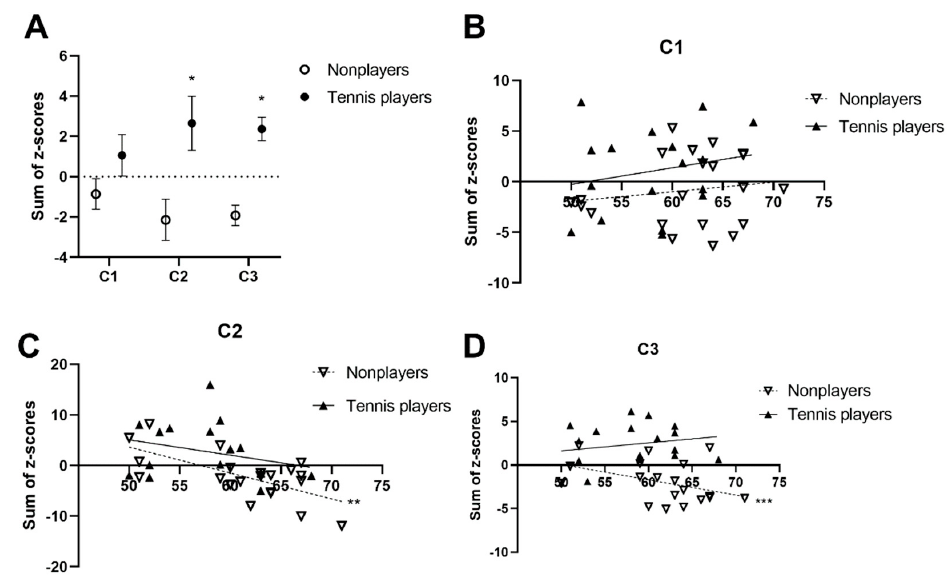
Figure 2. * p < 0.05 was considered statistically significant. ** p < 0.01 and *** p < 0.001 indicate a varying level of significance. Comparison of the cluster scores between the tennis players and nonplayers (A); Correlation of C1, C2, and C3 with increasing age between the tennis players and the nonplayers (B–D). Cluster 1 (C1) represents the cardiac function and is the summary of the z-scores for the HR, SVI, CI, SV, CO, and EF; Cluster 2 (C2) represents the arterial function and is the summary of the z-scores for the FMD, WSS, CIMT, baPWV, ABI, PSV, and CAED; Cluster 3 (C3) represents the body composition function and is the summary of the z-scores for the BMI, BMP, BFM, and LBM.